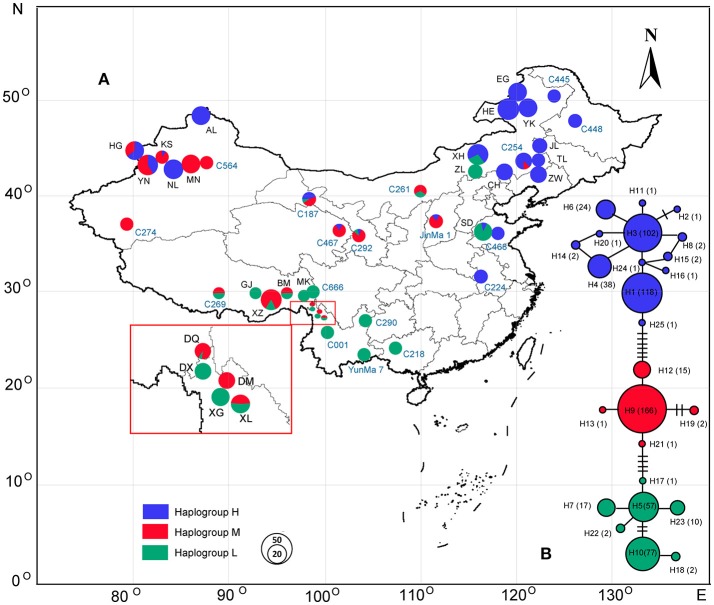
Geographic location of the 43 populations of Cannabis analyzed in the present study and haplogroup distribution patterns of Cannabis (see Table 1 for population codes); population codes in black represent the wild samples and blue ones are the domesticated accessions. (B) The haplotype network generated from the 25 haplotypes of Cannabis; pie chart size corresponds to the sample size of each population (A) or haplotype (B).